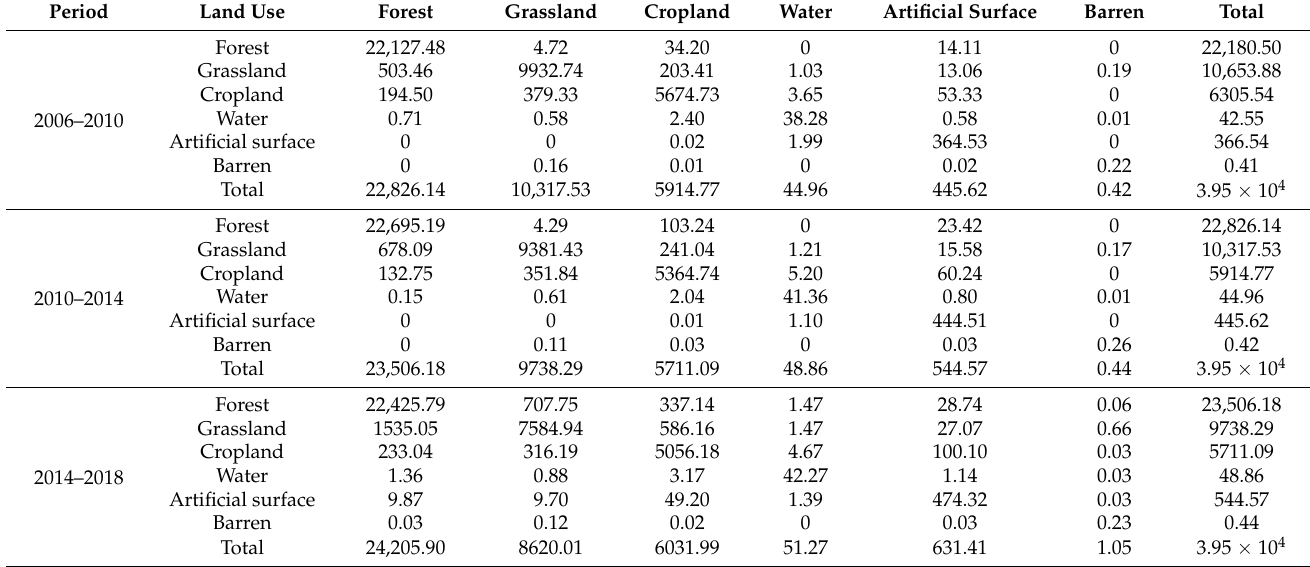
Table 1. Land use conversion matrix during 2006–2018 (km 2